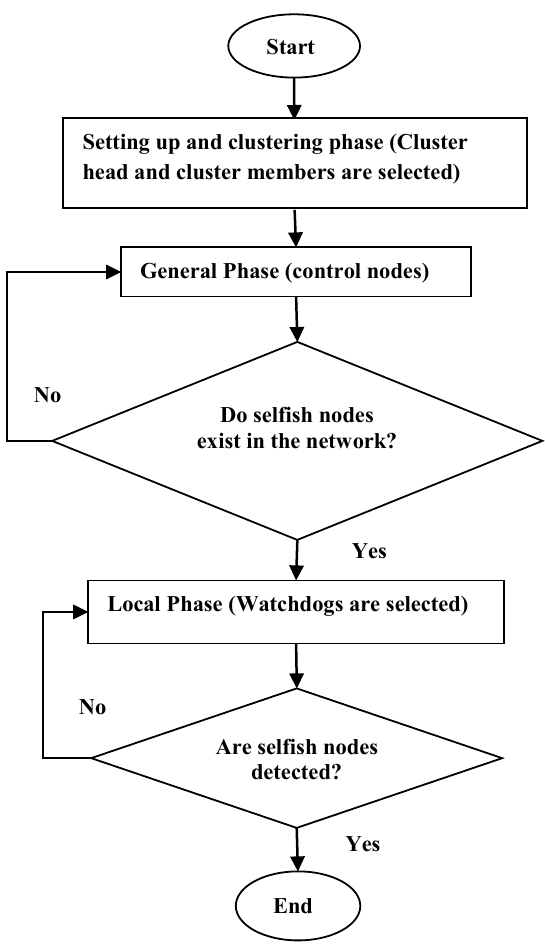
Fig. 2. Flowchart of the proposed